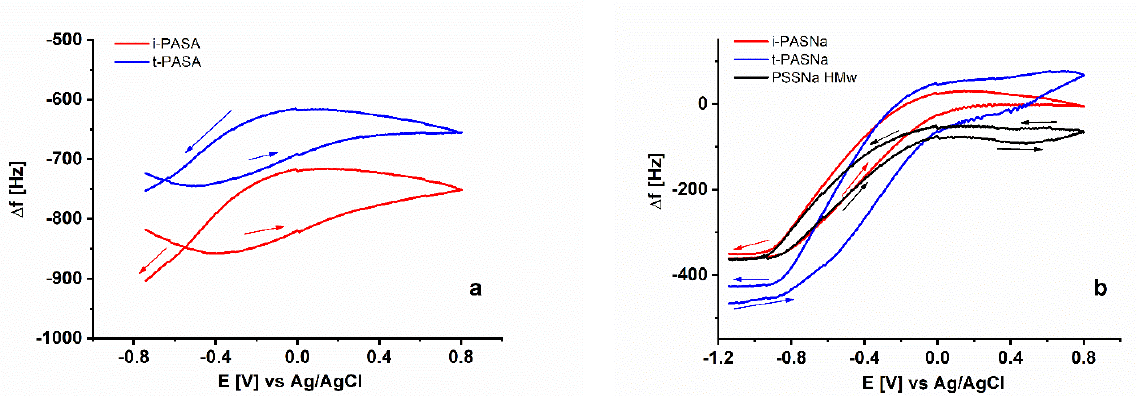
Figure 6. Frequency change as a function of potential in the course of electrochemical redox switching of PEDOT films obtained in the presence of ( a ) i-PASA (red) and t-PASA (blue), and ( b ) i-PASNa (red), t-PASNa (blue) and PSS Na (HMw) (black).